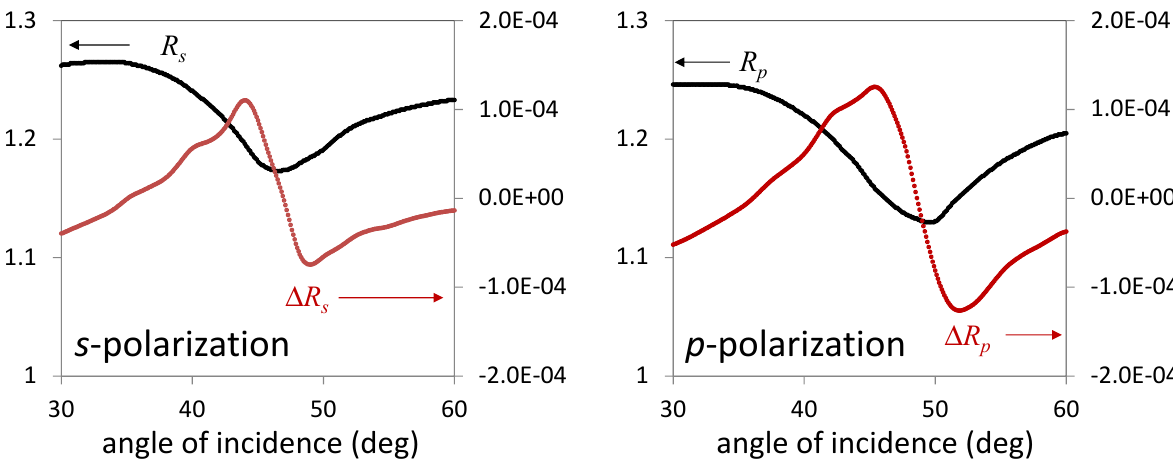
Figure 10. Experimental results from AJLZ53/APC. The measured reflectivities (Rs and Rp: left axis) and modulated reflectivities (Rs and Rp: right axis) as a function of